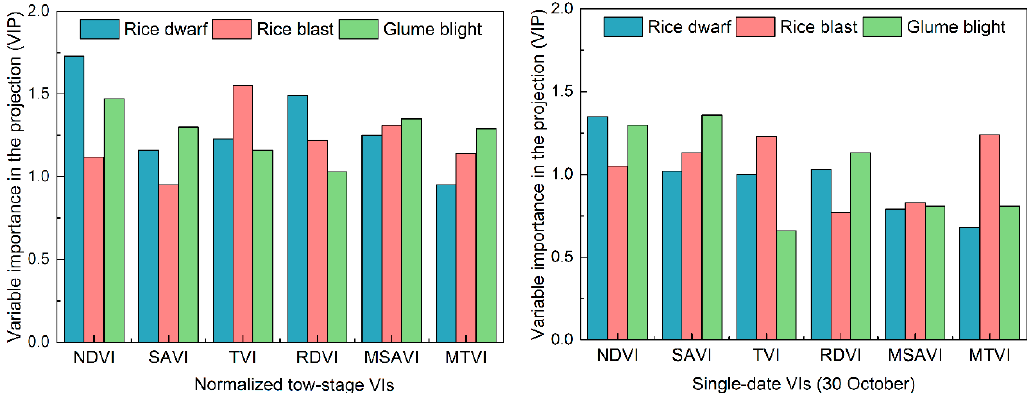
Figure 5. The importance of VIs for the detection of rice diseases as determined by the variable importance in the projection (VIP) method. Normalized two-stage and single-date VIs are projected as VIP scores. VIP